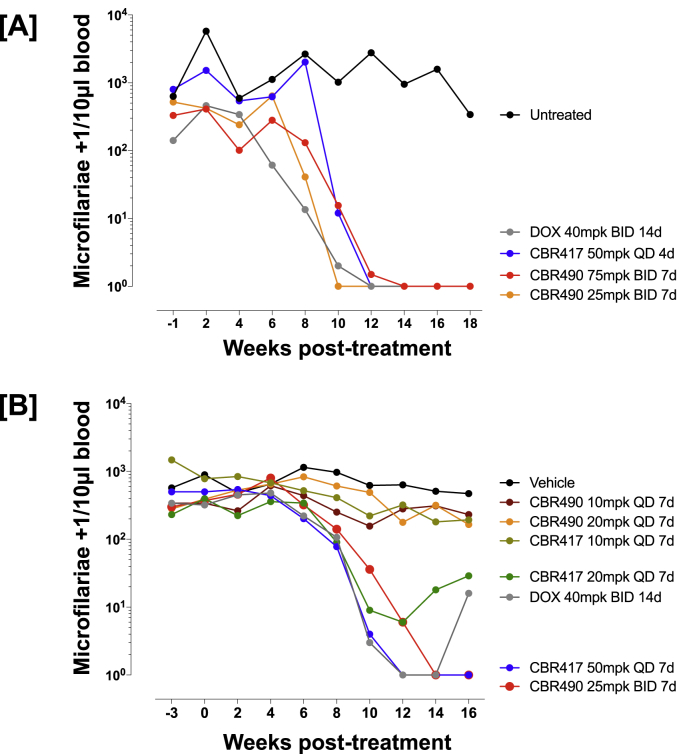
Microfilariae levels decline in response to CBR417 and CBR490 treatment. Mf count per 10 μL of blood drawn from jirds infected with L. sigmodontis and that have been treated with doxycycline (DOX), CBR417, CBR490, vehicle control or left untreated. A: 13-week-infected jirds were either left untreated (Image 2) or treated bi-daily (BID) with 40 mg/kg doxycycline for 14 days (Image 3), once per day (QD) with 50 mg/kg CBR417 for 4 days (Image 4) or BID with 75 (Image 5) or 25 mg/kg (Image 6) CBR490 for 7 days. B: 16-week-infected jirds were either treated BID with vehicle control for 7 days (Image 7), BID with 40 mg/kg doxycycline for 14 days (Image 8), QD with 50 (Image 9), 20 (Image 10) or 10 (Image 11) mg/kg CBR417 for 7 days, QD with 20 (Image 12) or 10 (Image 13) mg/kg CBR490 for 7 days or BID with 25 mg/kg CBR490 for 7 days (Image 14). Jirds were sacrificed 16 (A) or 18 (B) weeks after treatment. N = 5–6 per group.